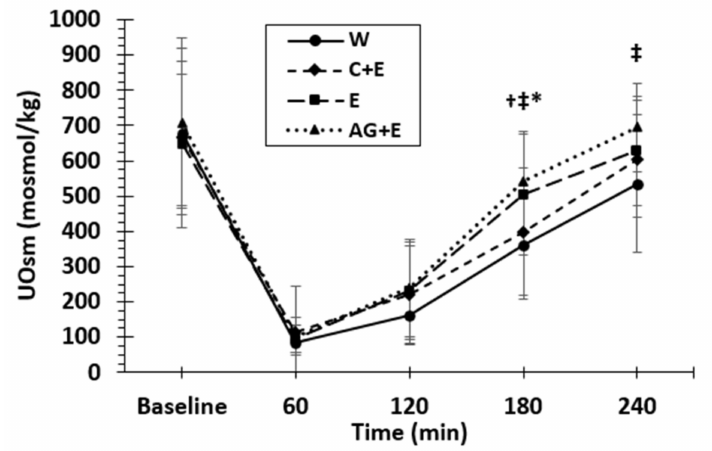
Figure 5. Mean ( ± SD) urine osmolality (UOsm) over time denoting significant differences between beverages. ‡ Difference between dipeptide-electrolyte (AG + E) vs. water (W); * Electrolyte (E) vs. W; † AG + E vs. carbohydrate-electrolyte (C + E) ( p < 0.05).